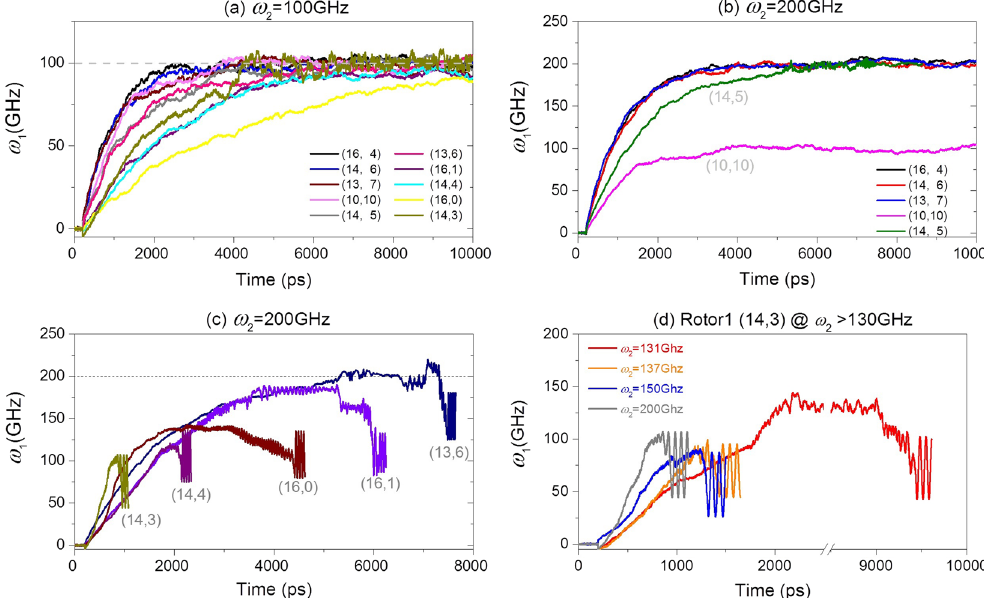
Figure 6. In the B-type model, the history curves of ω 1 of Rotor1 when driven by Rotor2 with different input rotational frequency of ω 2